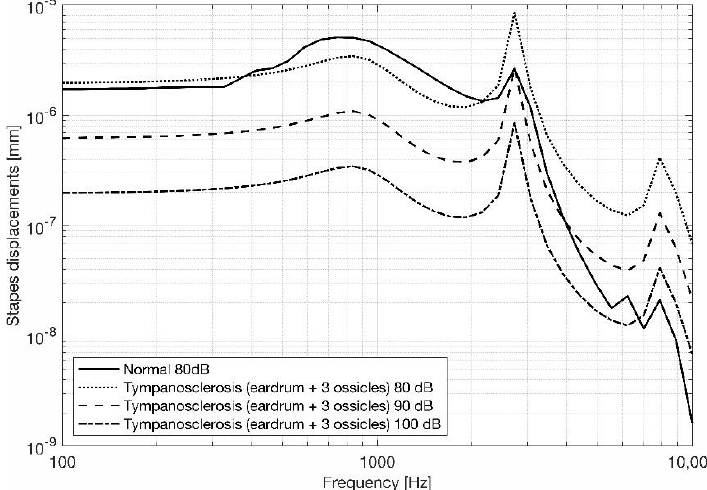
Figure 12. Stapes footplate displacements, comparing the different sound pressure applied.